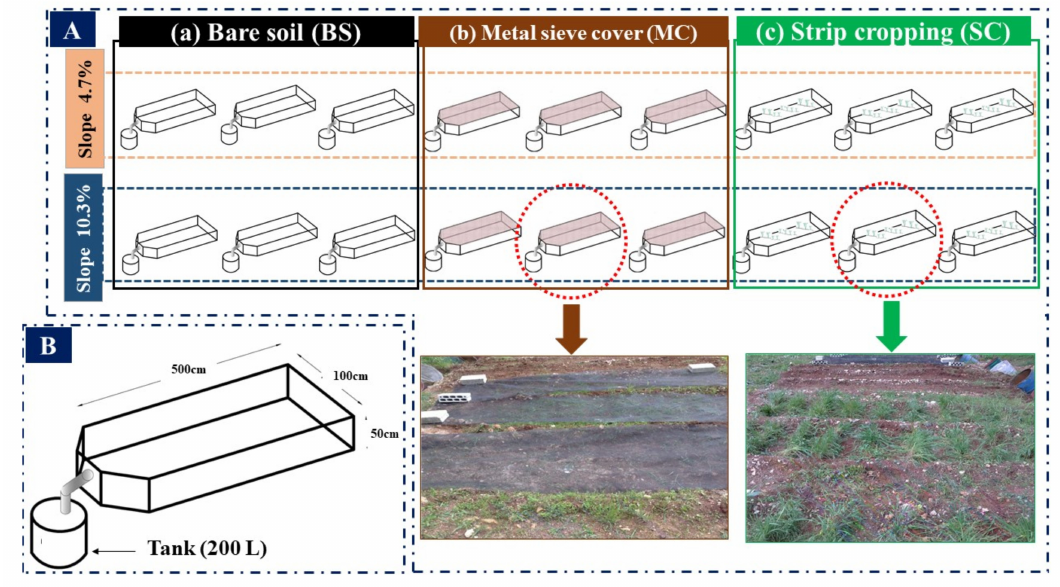
Figure 2. ( A ) Field experimental design in two di ff erent slope inclination (4.7%, 10.3%), ( a ) nine plots of bare soil (BS), ( b ) nine plots of metal sieve cover (MC), and ( c ) nine plots of strip cropping (SC). ( B ) sketch of experimental plot (500 cm × 100 cm × 50